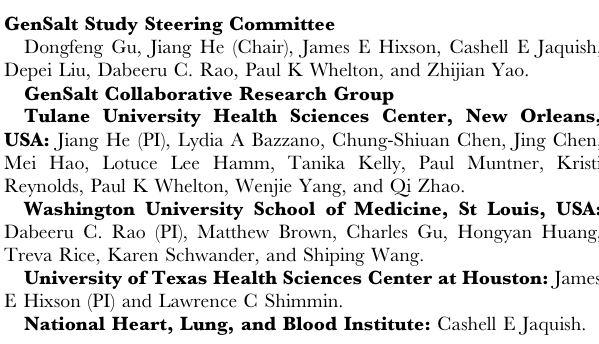
Table S1 SNP characteristics. Detailed information about the 193 SNPs used in